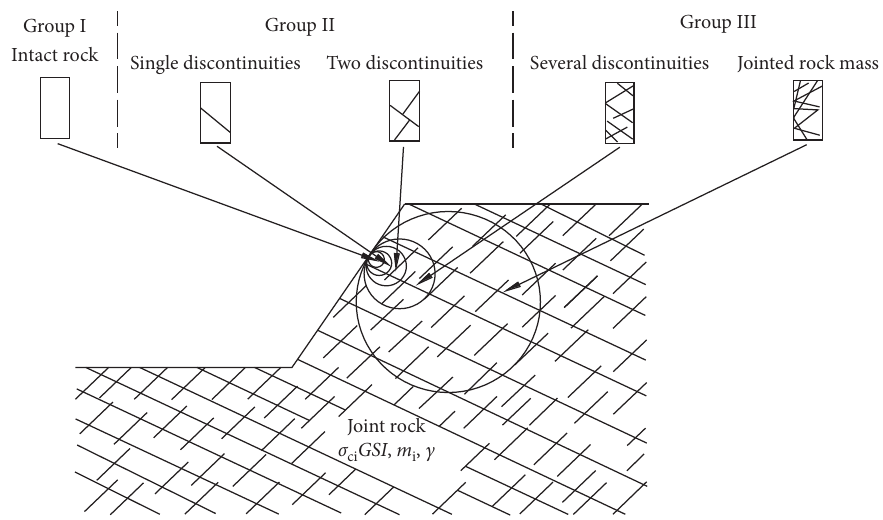
Figure 1: Applicability of the HB failure criteria for the rock slope